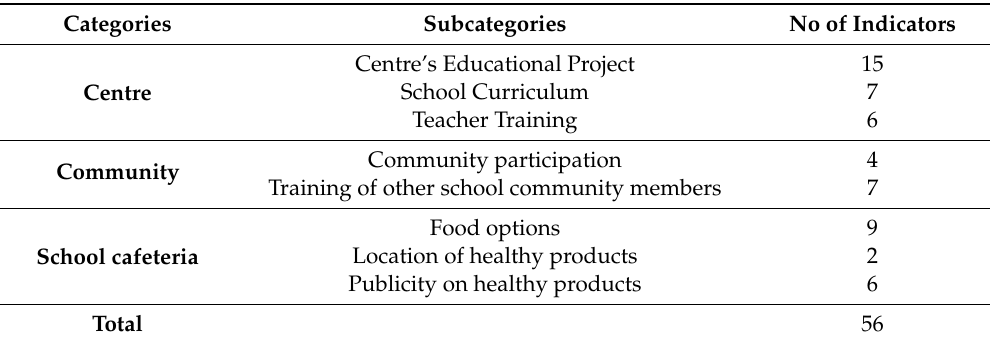
Table 1. Indicators of healthy-eating